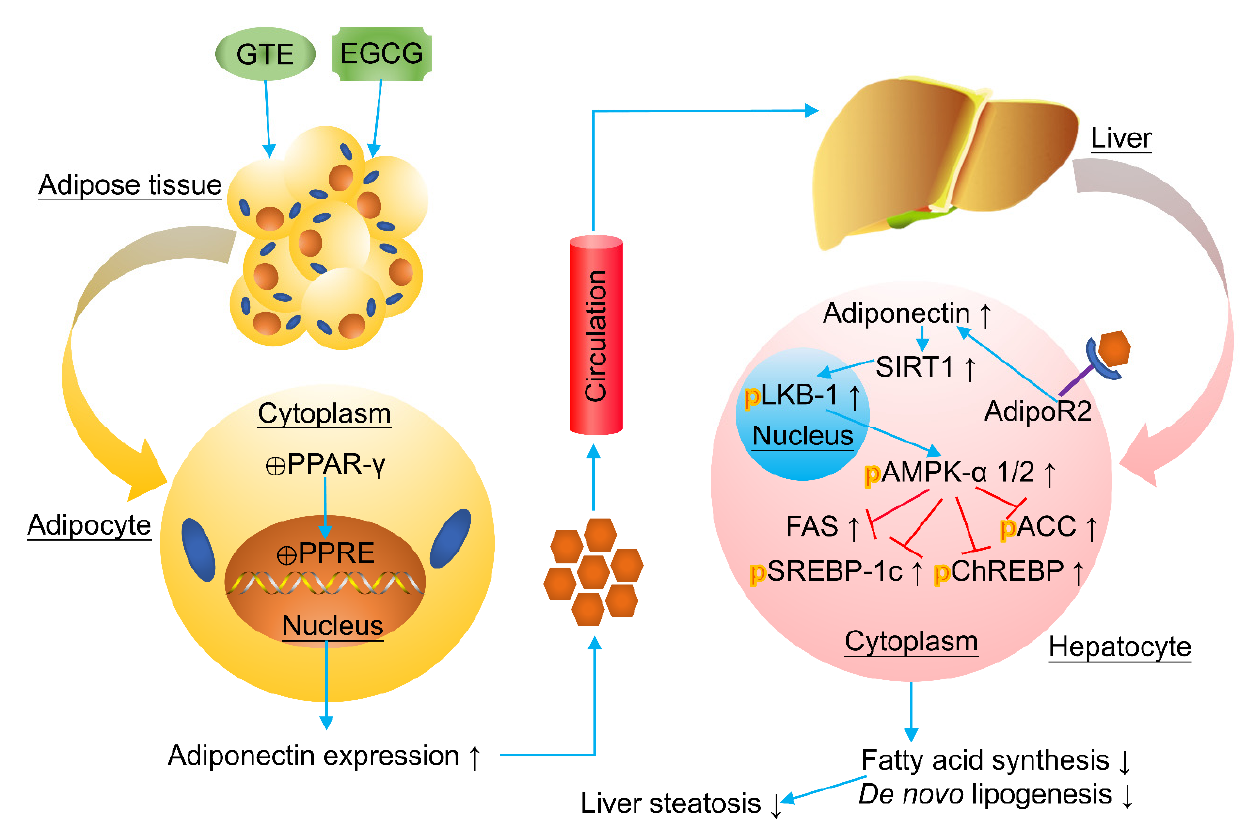
Figure 3. Green tea extract (GTE) and epigallocatechin gallate (EGCG) may ameliorate liver steatosis in NAFLD by improving lipid metabolism via targeting SIRT1 and AMPK signaling pathways. Abbreviations: PPAR- γ , peroxisome proliferator-activated receptor γ ; PPRE, PPAR-responsive element; AdipoR2, adiponectin receptor 2; SIRT1, sirtuin 1; LKB1, liver kinase B1; AMPK, AMP-activated protein kinase; FAS, fatty acid synthase; ACC, acetyl-CoA carboxylase; SREBP-1c, sterol element-binding protein 1c; and ChREBP, carbohydrate response element-binding protein.